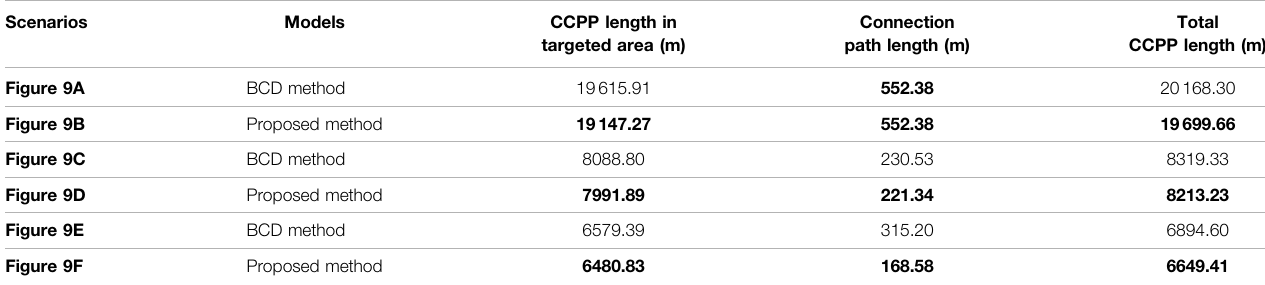
The best results compared from two models are speci fi ed in